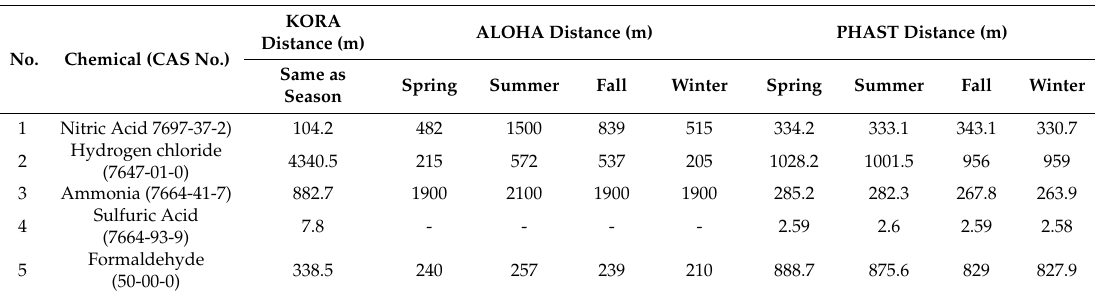
Table 8. Seasonal damage distances by three modeling programs.